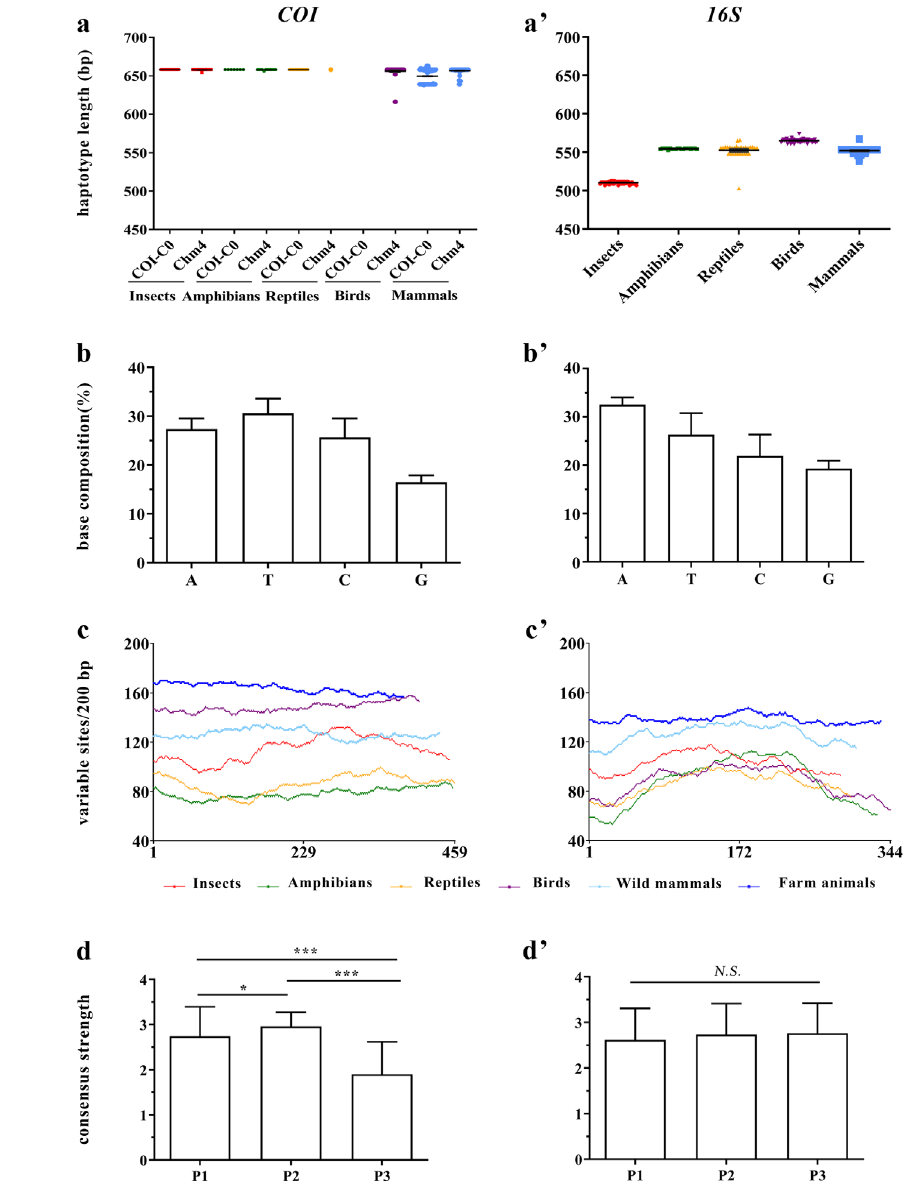
Figure 2. Isolation and characterization of COI and 16S barcodes. (a-b’) Sequence length and average nucleotide composition of COI (a and b) and 16S (a’ and b’) haplotypes. (a and a’) Each dot represents a unique haplotype. (c and c’) Sliding window graph comparing the number of variable sites for COI and 16S haplotypes. Each window size of 200 bp is slid through the full segment 1 bp at a time, resulting in 459 windows for COI (c) and 344 for 16S (c’). Animal groups are indicated by lines with different colors. (d) Variation of the triplet code of COI haplotypes. Consensus strength is scored according to the Alignment Report given by MegAlign using Lasergene software package and plotted according to the positions of genetic code. (*) p<0.05; (***) p<0.001. The same rules are applied to non-coding 16S haplotypes but the codon positions are defined randomly (d’). (N.S.) not